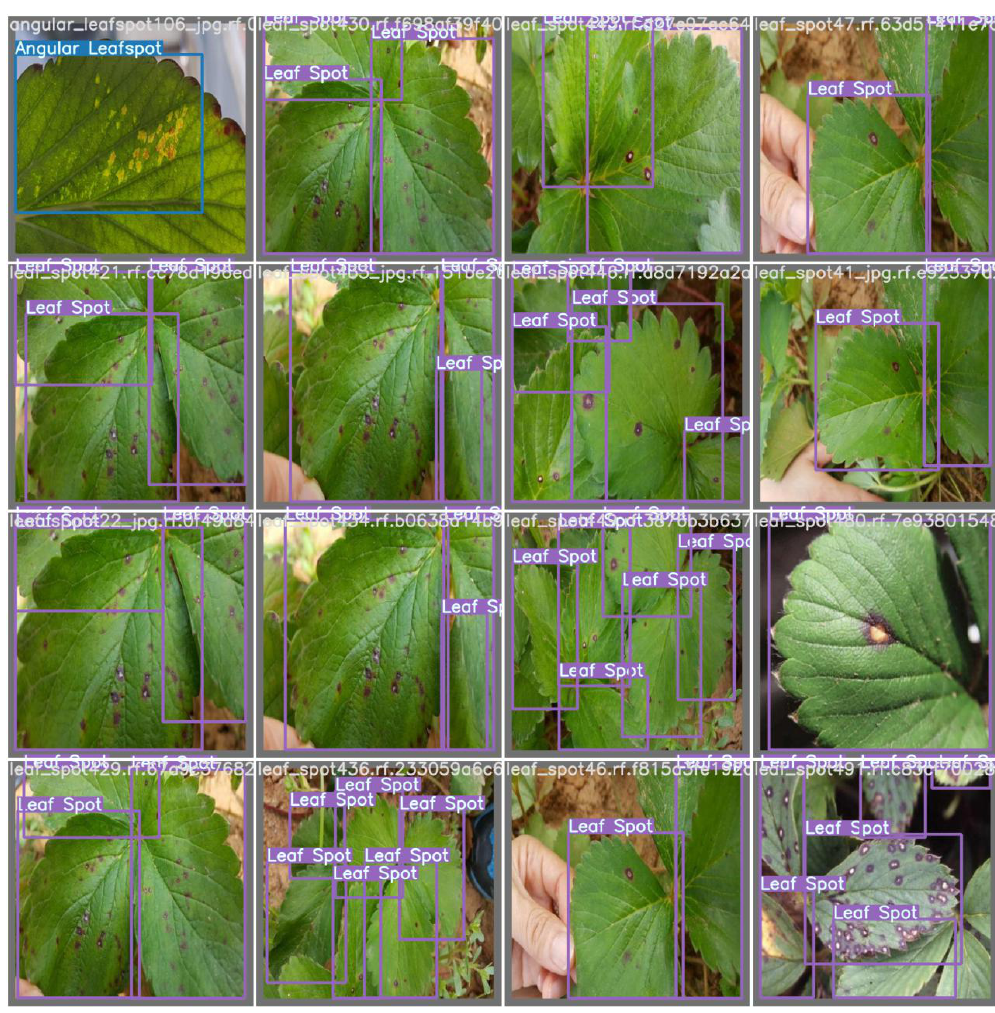
Figure 10. Ground truth data used to train the